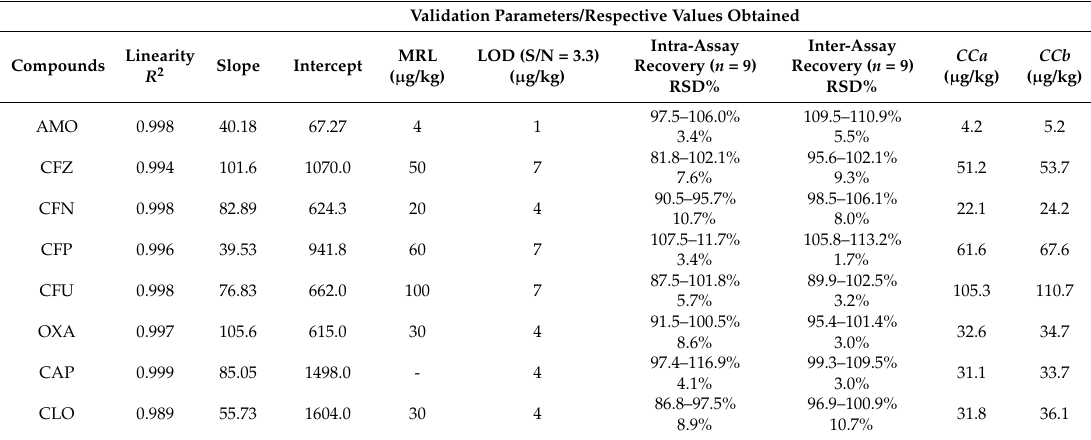
Table 3. Validation parameters for the determination of β -lactams and chloramphenicol in milk. Validation Parameters/Respective Values